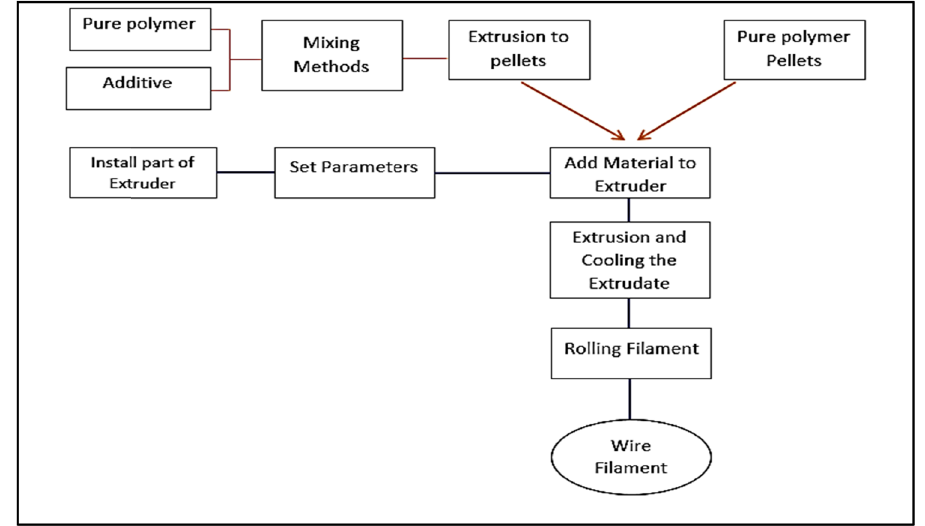
Figure 1: Filament work fl